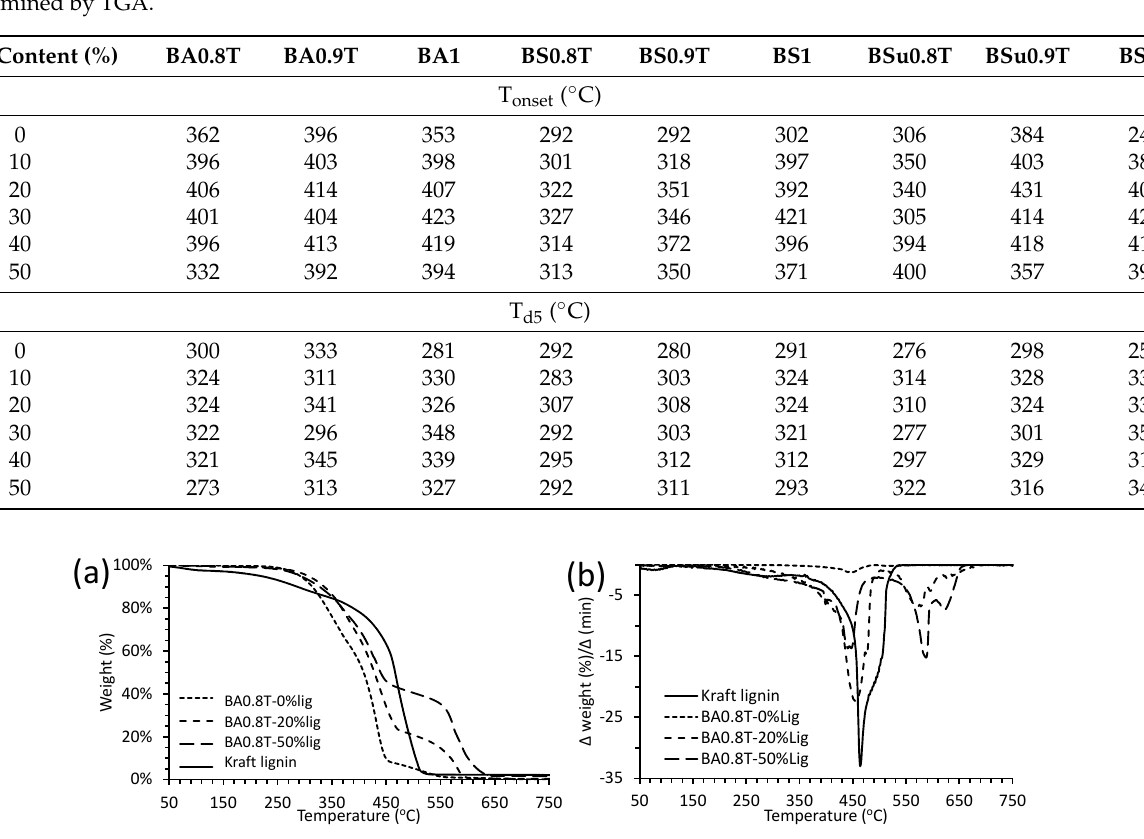
Figure 7. ( a ) TGA and ( b ) DTG thermograms of kraft lignin and BA0.8T-0, 20, 50%lignin copolymers.